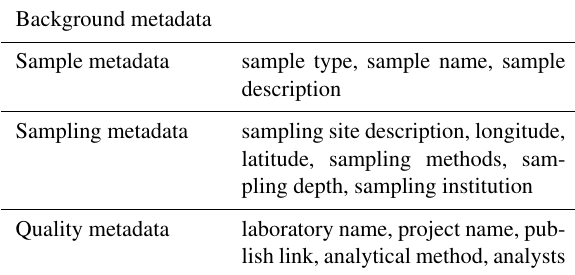
Table 1. Background metadata of geoanalytical